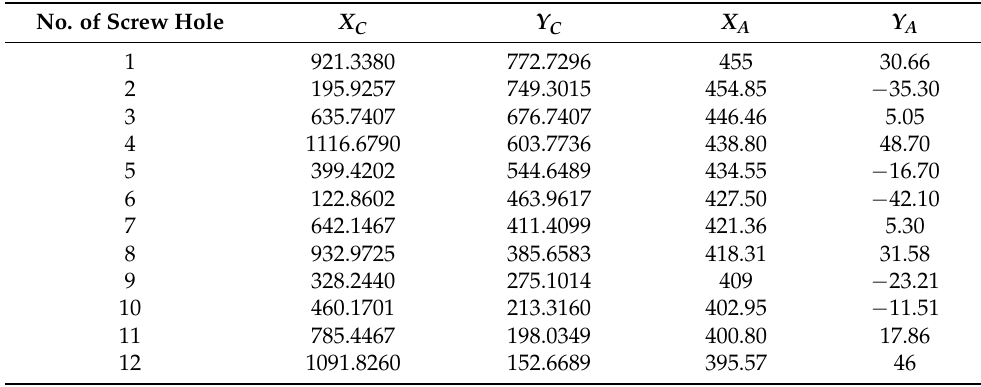
Table 2. Camera 1 and manipulator measurement